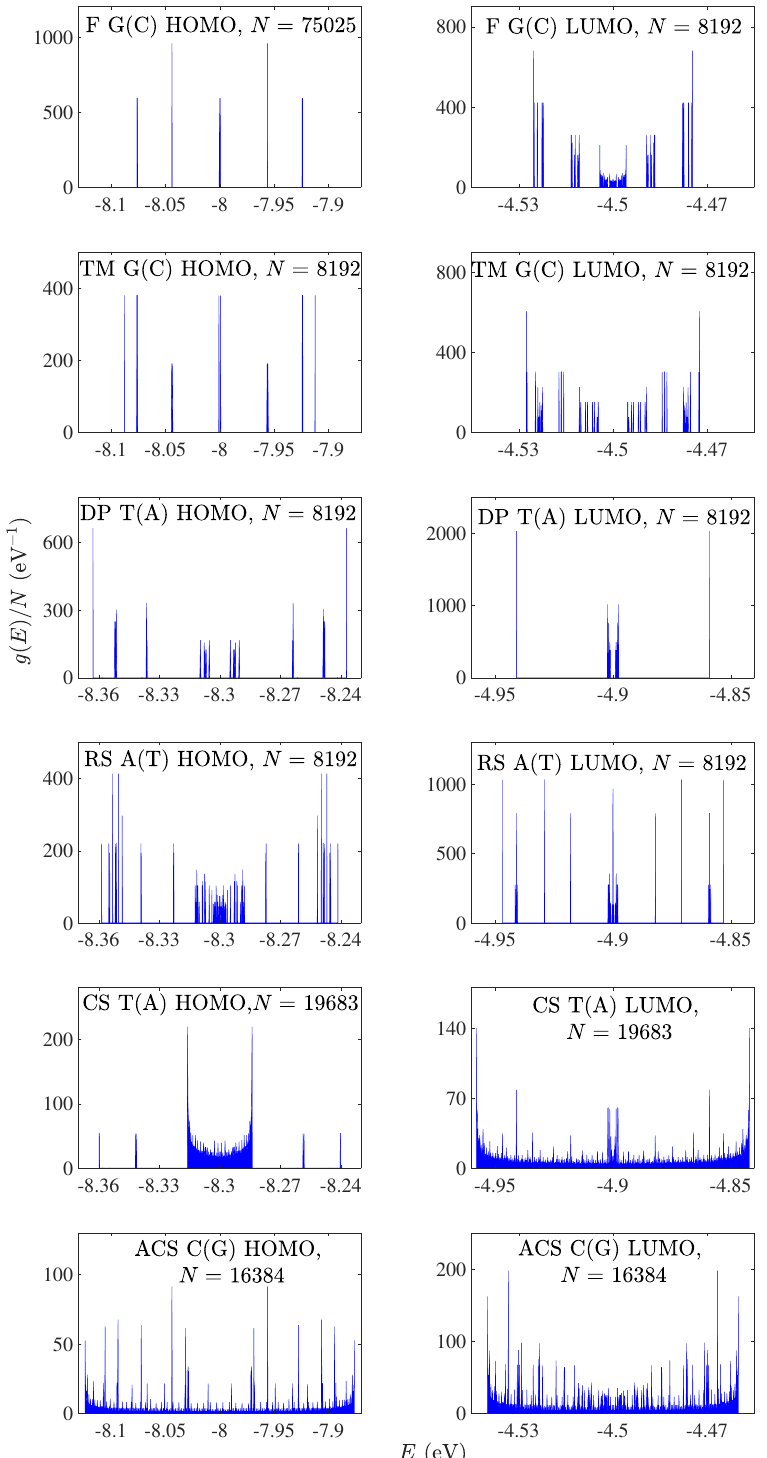
Figure 3. Density of states of F G(C), TM G(C), DP T(A), RS A(T), CS T(A), ACS C(G) polymers, for the HOMO (left column) regime and the LUMO (right column) regime, for a generation with large N . The notation of polymers is given in Table